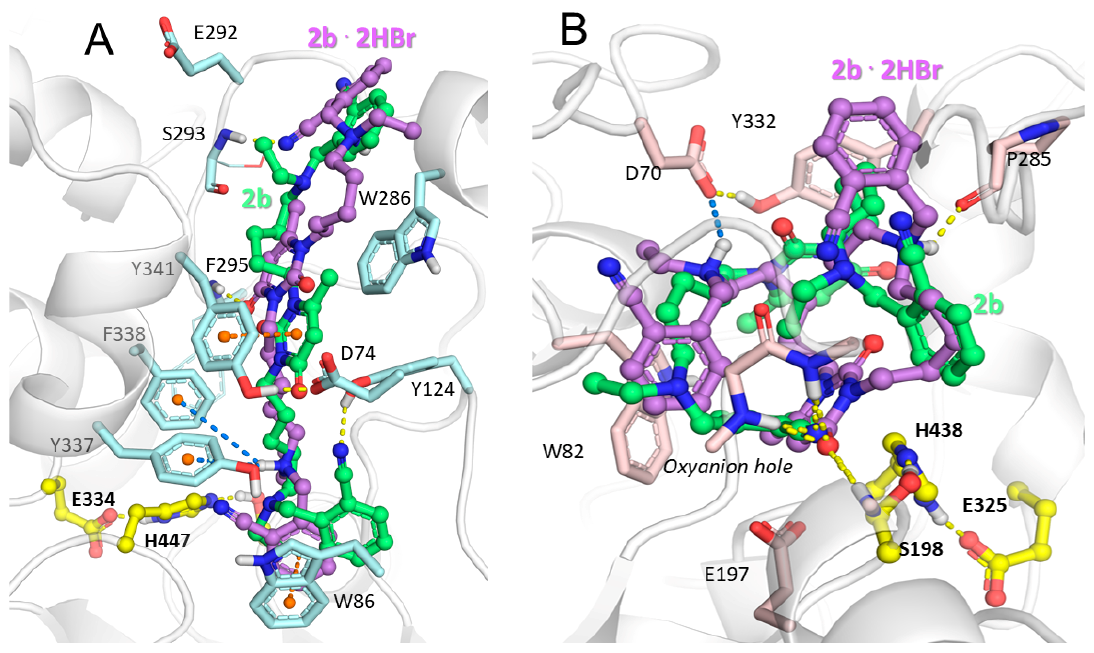
Figure 2. Binding poses of 6-methyluracil 2b (carbon atoms are shown in green) and its charged counterpart 2b · 2HBr (carbon atoms are shown in violet) inside active site gorges of ( A ) hAChE and ( B ) hBChE. Yellow, dashed lines represent hydrogen bonds, orange represents π – π stacking interactions, and blue lines indicate ionic and π –cation interactions. The catalytic triads of the enzymes are indicated using yellow carbon atoms.